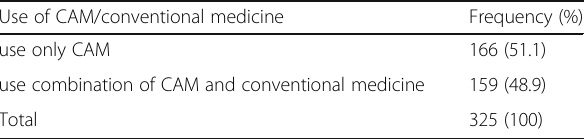
Table 7 Use of CAM and conventional medicine. n = 325 Use of CAM/conventional